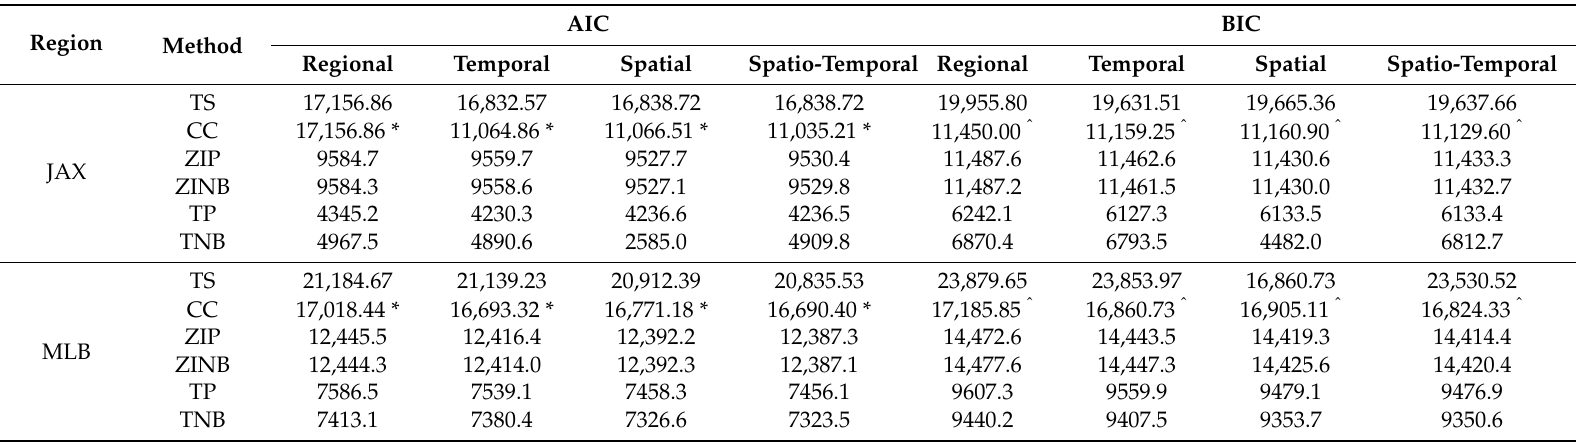
Table 7. Akaike Information Criterion (AIC) and Bayesian Information Criterion (BIC), for the Time-series (TS), Case-Crossover (CC), Zero-Inflated Poisson (ZIP), Zero-Inflated Negative Binomial (ZINB), Truncated Poisson (TP), and Truncated Negative Binomial (TNB) studies for the JAX and MLB region.